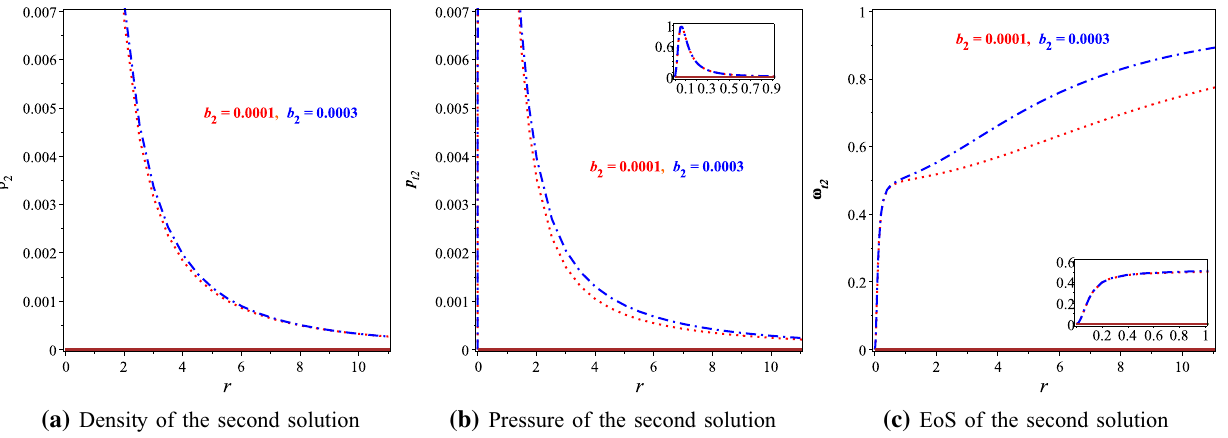
Fig. 2 Schematic plot of the radial coordinate r in the unit of km versus the energy density, pressure and the EoS of the solution (20) when b 0 = 0 . 0001 and b 1 = 0 .